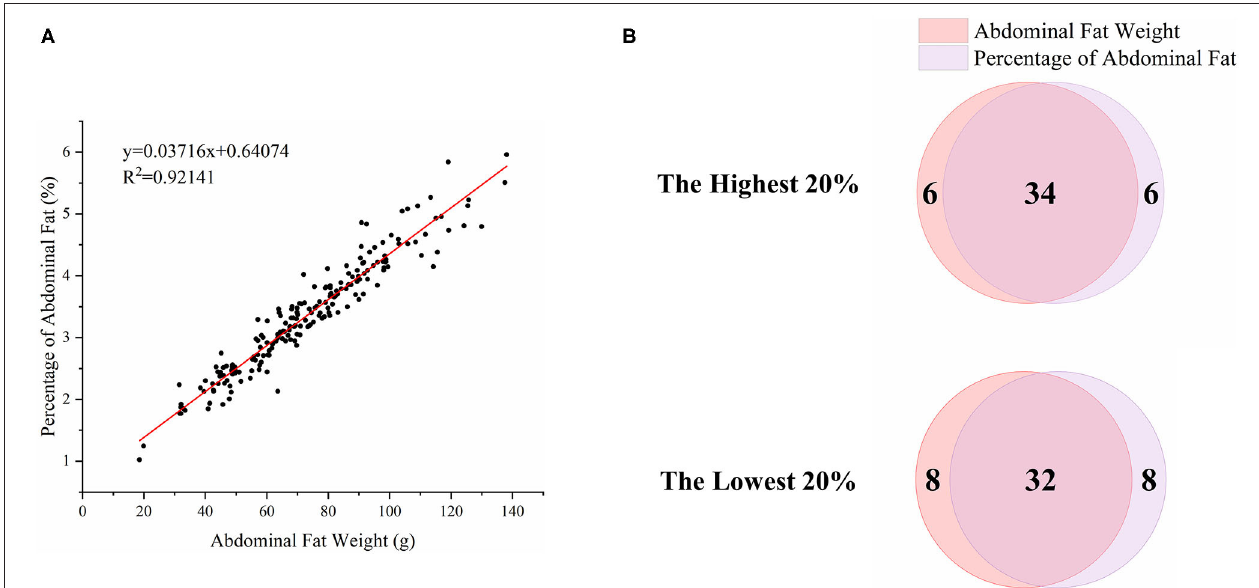
FIGURE 2 | Association analysis of abdominal fat weight (AFW) and percentage of abdominal fat (AFP). (A) . The correlation between AFW and AFP. (B) . Overlap analysis of the shared birds in both AFW- and AFP-ranked groups of the highest 20% ( n = 40) and lowest 20% ( n = 40).